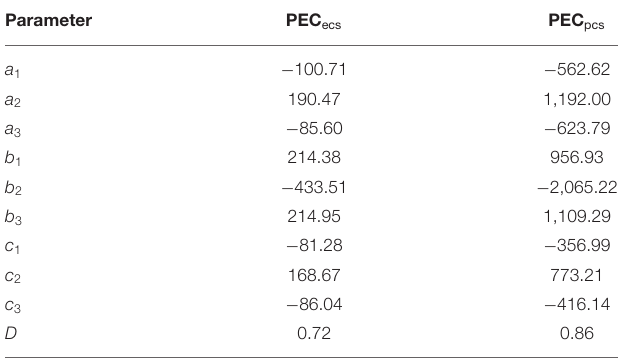
TABLE 7 | TI-PTES cost correlation